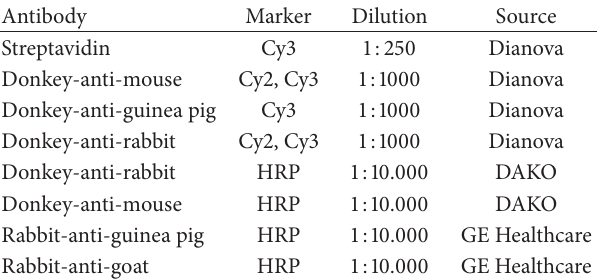
Table 2: Used secondary